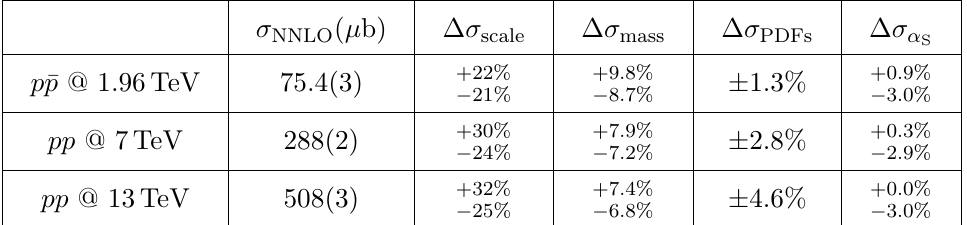
Total cross sections and uncertainties for b (cid:22) b production at NNLO for (cid:22) 0 = m b . The numerical errors on the last digits are stated in brackets, as in Table